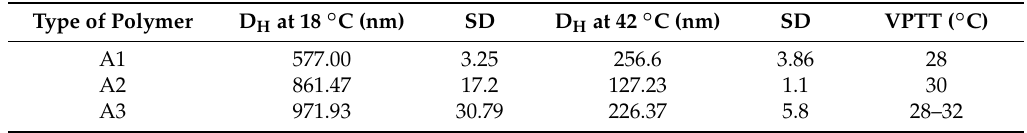
Table 1. Hydrodynamic diameter D H and volume phase transition temperature (VPTT) values at 18 and 42 °C temperatures of the synthesized polymers.